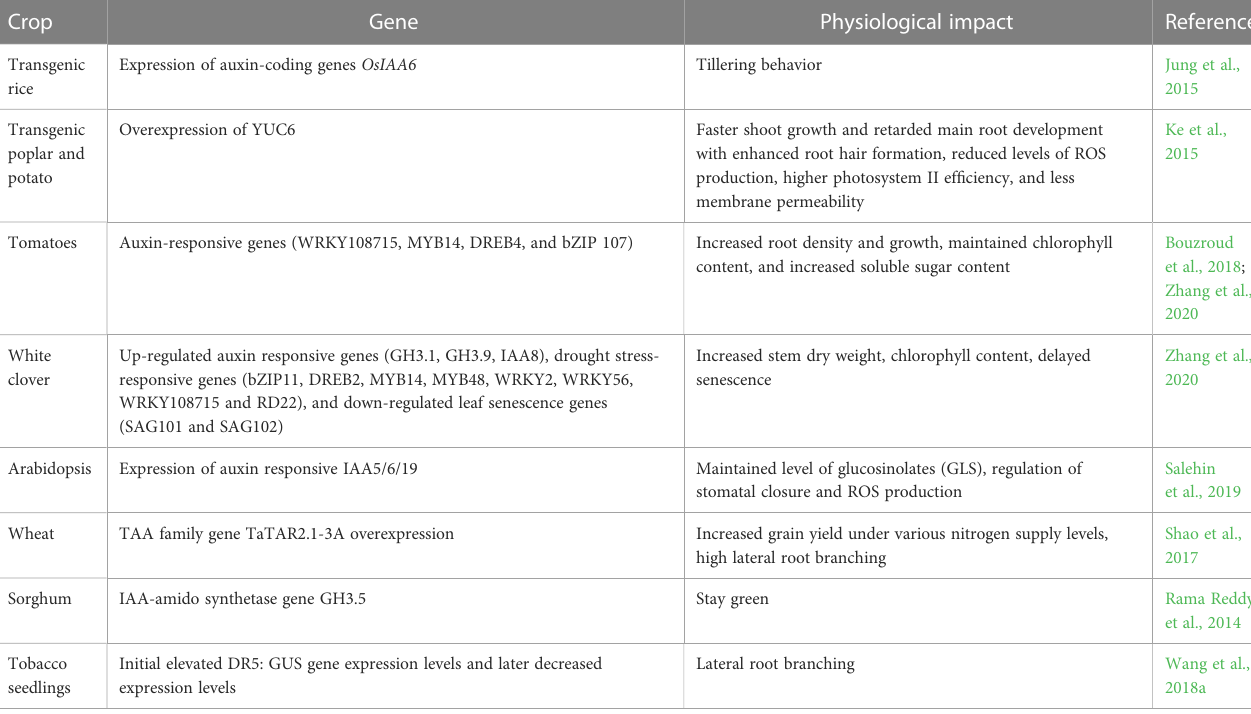
TABLE 4 Impact of auxin-linked gene on stress response. Crop